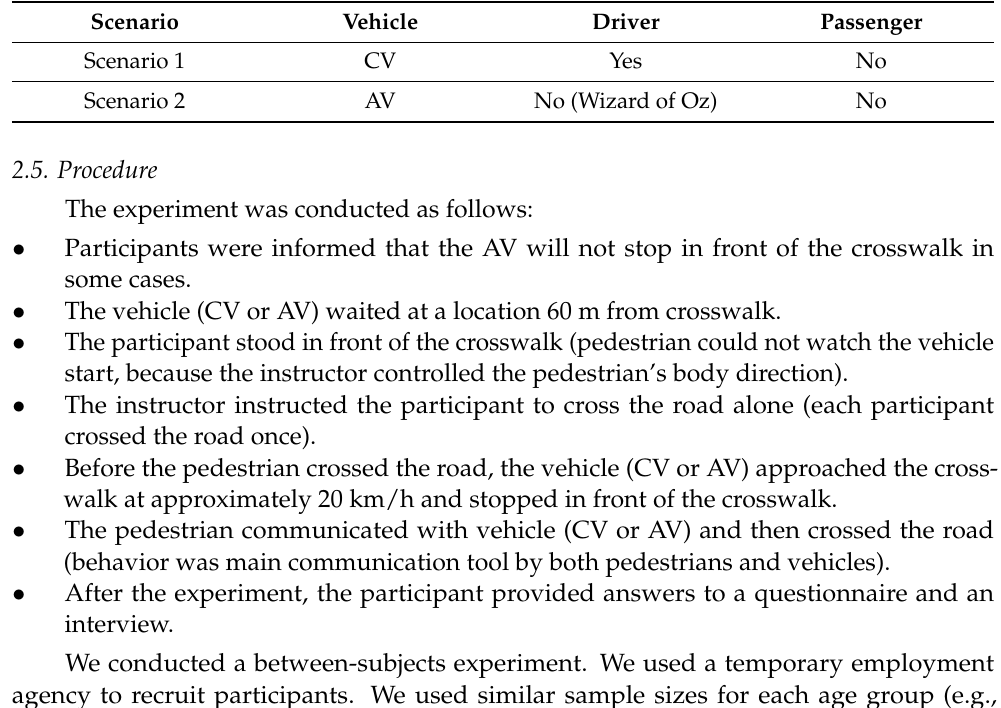
Table 1. Conditions of Scenario 1 and 2.